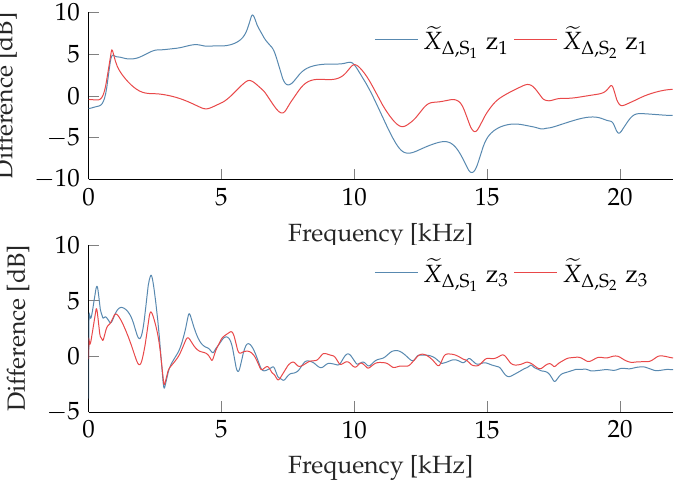
Figure 14. Comparison of the difference spectra (cid:101) X ∆ ,S